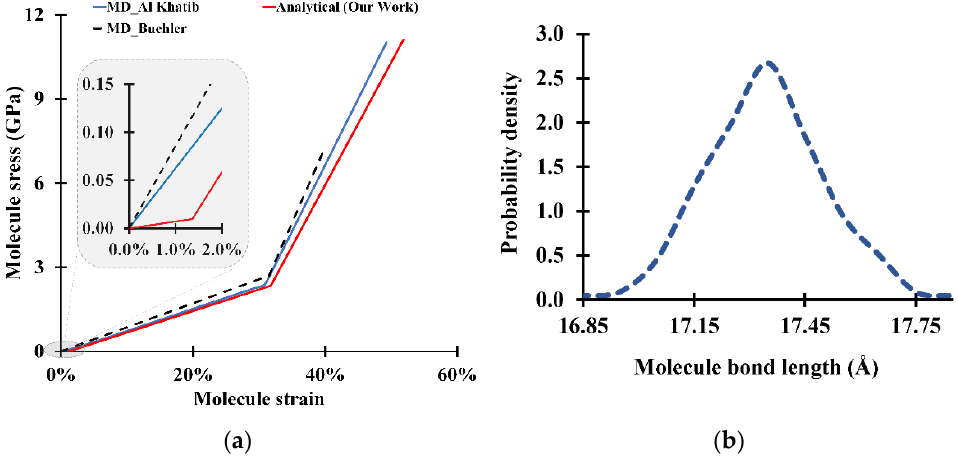
Figure 5. Tropocollagen molecule response to tensile load: ( a ) stress–strain curve for the tropocollagen molecules under tensile load (Al khatib et al., [29] and Buehler et al., [42]); ( b ) bond length distribution along tropocollagen molecule at a strain of 25%.